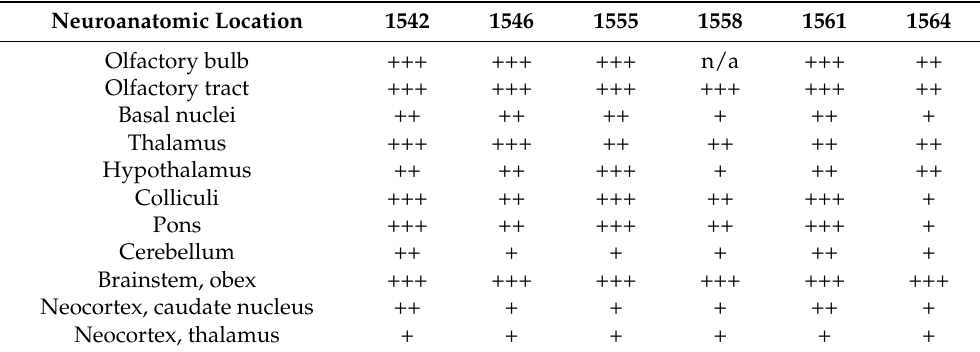
Figure 2. Immunolabeling of PrP Sc in the gastrointestinal tract of white-tailed deer inoculated with raccoon-passaged CWD. There is positive immunolabeling of PrP Sc (red) in the mucosal-associated lymphoid tissue ( A ) and submucosal and myenteric plexuses ( B ) of the small intestine. Immunolabeling is present in the myenteric plexus of the reticulum ( C ) and abomasum ( D ). Immunohistochemistry, F99 monoclonal antibody. Original magnification ( A – C ), 100×; ( D ), 200×. To gauge the relative accumulation of PrP Sc throughout the brain of each individual Small congophilic plaques that demonstrated apple-green birefringence under polar- deer, the degree of immunolabeling was compared semi-quantitatively (Figure 3). izing light were infrequently observed in some deer brains. Congophilic plaques reacted with anti-prion antibody. Table 2. Relative amount of PrP Sc throughout the brain in individual white-tailed deer inoculated with raccoon CWD based on